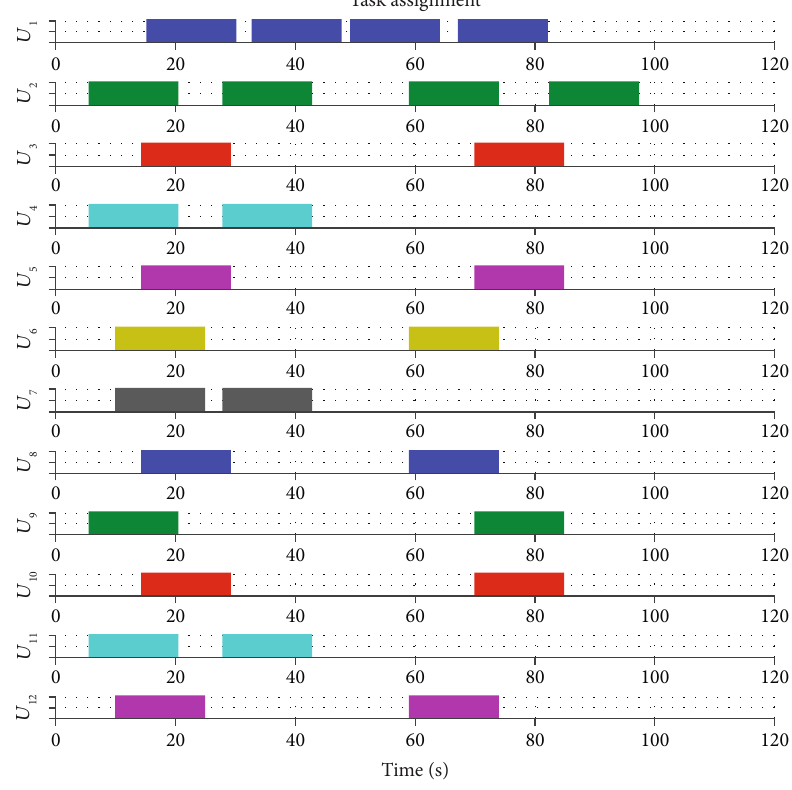
Figure 7: The task sequence obtained by the two-layer algorithm. Table 7: The task assignment result obtained by the two-layer algorithm.